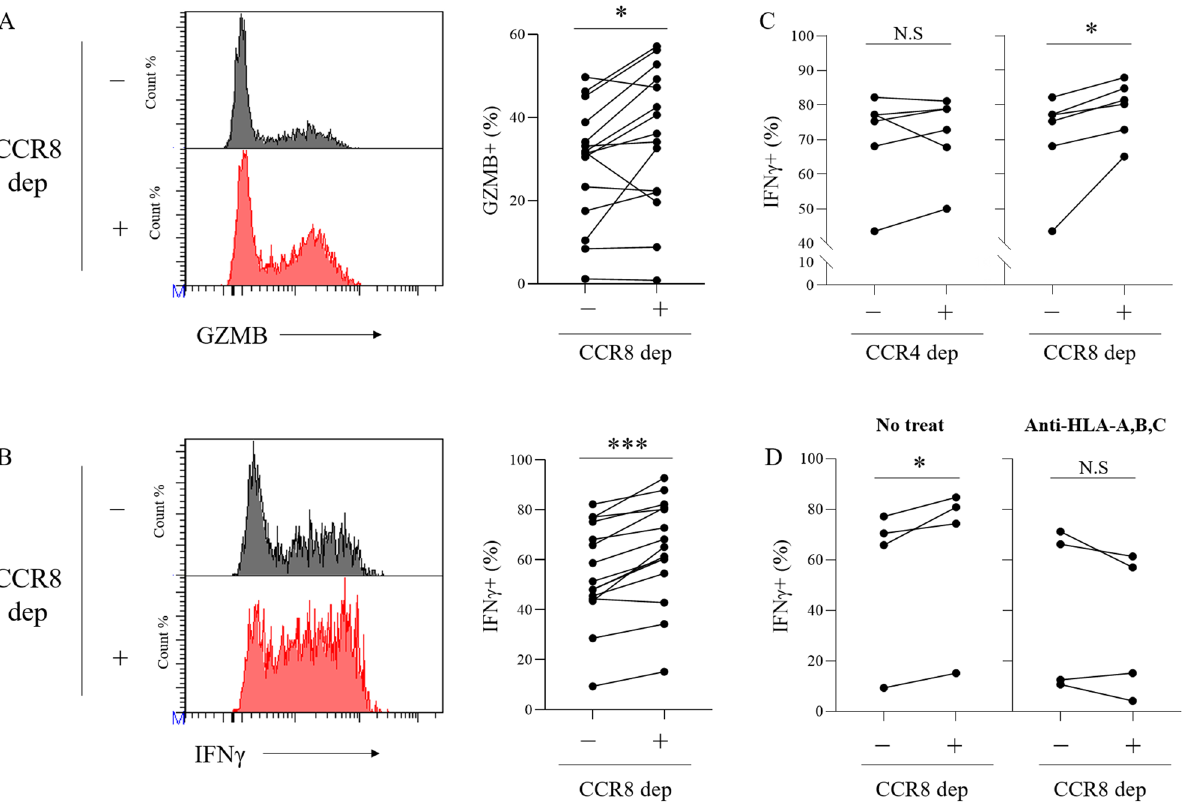
Figure 5. Impact of CCR8+ cell depletion on CD8 T cells in lung tumors. CCR8+ cells were magnetically removed from TICs of lung cancer and cultured with IL-2 and CpG. After 5 days, CD8 T cells in TICs were detected by flow cytometry. ( A ) Representative flow cytometric data (left) and the percentage of GZMB- expressing cells (right) in CD8T cells (gated on live CD45+ CD3+ CD8+ cells) are shown (n = 15). ( B ) Representative flow cytometric data (left) and percentage of IFNγ-producing cells (right) in CD8 T cells after PMA/ionomycin stimulation are shown (n = 15). ( C ) Percentages of IFNγ-producing cells in cultured CD8 T cells after CCR8+ cell and CCR4+ cell depletion (n = 5). ( D ) After depletion of CCR8+ cells, TICs were cultured in the presence of anti-HLA-A,B,C antibody for 5 days. Percentages of IFNγ-producing cells in CD8 T cells were detected by flow cytometry (n = 4). Lines connect data from the same donor samples. Statistical significance was determined by paired t-test (* p ≤ 0.05; ** p < 0.01; *** p < canceled the CD8 T cell activation by CCR8+ cell depletion. Tumor antigen is taken up and processed by APCs and presented to CTLs by MHC class I 11,27 . Blocking of MHC class I inhibits this process. Thus, CCR8+ Tregs were considered to suppress CD8 T cell activation via APCs. Third, we directly evaluated the immune suppressive function of CCR8+ Tregs in CTL cytotoxicity using CCR8+ Tregs induced from PBMCs. In the co-culture with CD8 T cells, only CCR8+ Tregs dramatically suppressed the cytotoxic ability of CD8 T cells in both the antigen non-specific model and the antigen-specific model. Interestingly, CCR8− Tregs did not suppress cytotoxicity in either model. We speculated that CCR8+ Tregs may be responsible for most Treg suppressive functions against CTL cytotoxicity. In these experiments, it took 4 days for CCR8+ Tregs to suppress CD8 T cell cytotoxicity, and CCR8+ Tregs did not suppress CD8 T cell cytotoxicity at earlier time points (data not shown). CCR8+ Tregs are likely to suppress the differentiation process of CD8 T cells to acquire CTL functions over the 4-day period. On